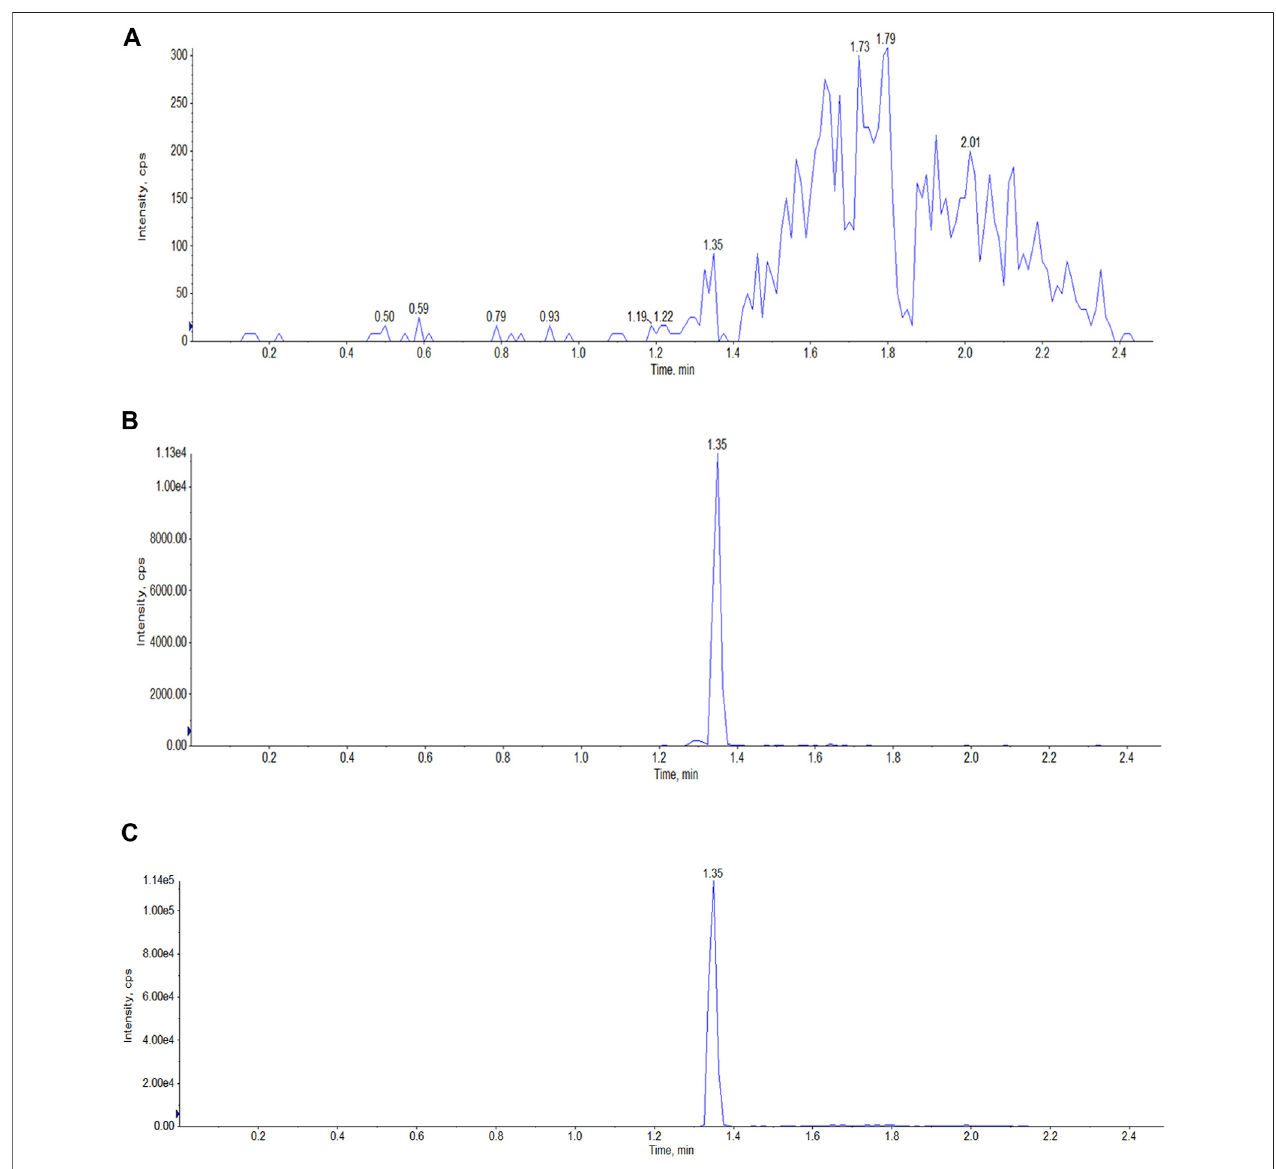
FIGURE 1 | Typical LC-MS/MS MRM chromatograms of Indo5 ( m/z 431.165/232.2) and IS ( m/z 472.3/436.3) in plasma. (A) blank plasma; (B) Indo5; (C) IS.